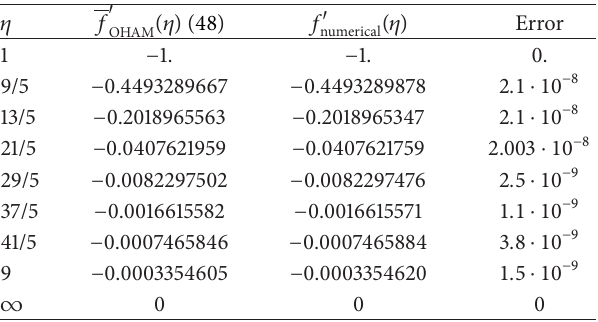
Table 3: Comparison between the derivative 𝑓 (48) and numerical results for 𝛾 = 1 and 𝑆 = −1 (error = | 𝑓 (𝜂)| ). 𝑓 󸀠 numerical